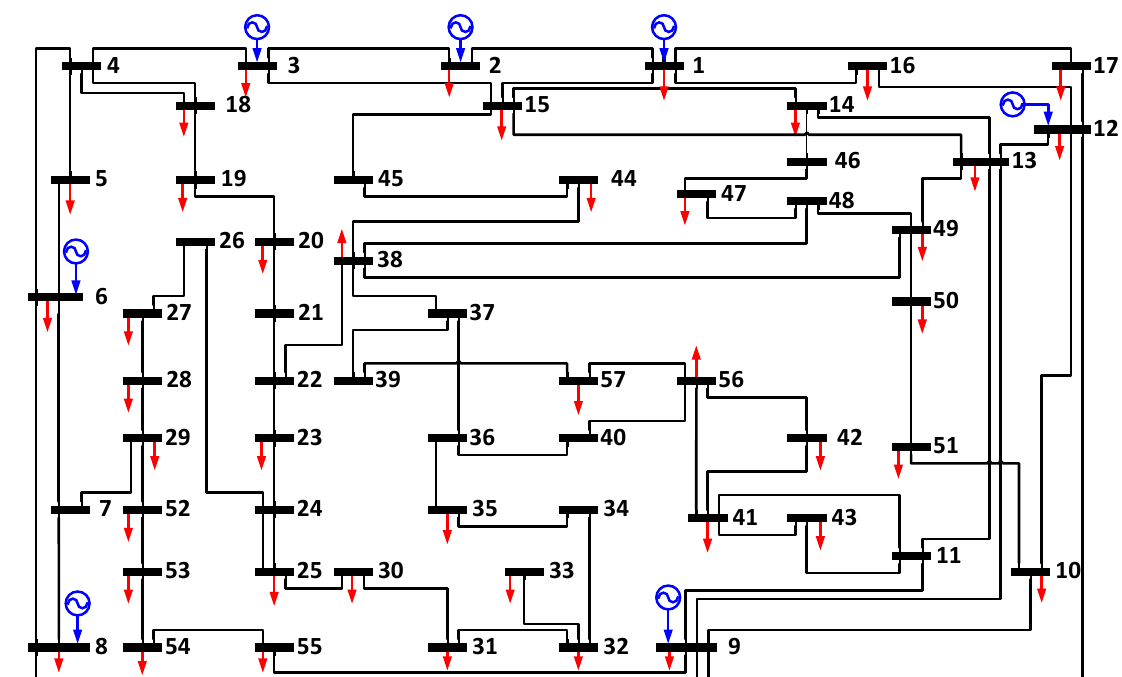
Figure 6. Single line diagram of the IEEE 57-bus